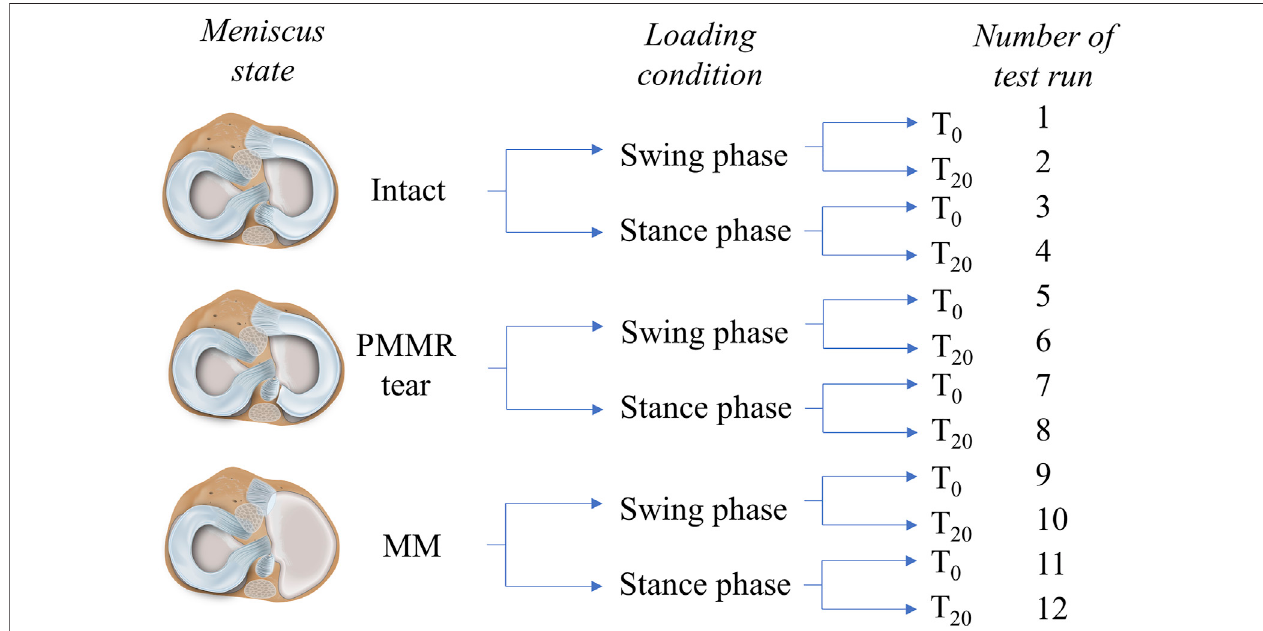
FIGURE 2 | Schematic overview of the testing routine. Three meniscus states were investigated in this study: intact, with a posterior medial meniscus root tear (PMMR tear) and after medial meniscectomy (MM). Two different loading conditions derived from an ovine gait cycle were applied to the joints: swing phase conditions (250 N axial loading and 12 ° initial de fl ection) and stance phase conditions (1000 N axial loading and 5 ° initial de fl ection) (Taylor et al., 2006; Taylor et al., 2011). Each meniscus state was fi rst tested under swing phase conditions followed bytests understance phase conditions. Both conditions were tested fi rst directlyafter load application (T 0 ) and second after 20 min resting under the axial loading (T 20 ). In total, each knee underwent 12 test